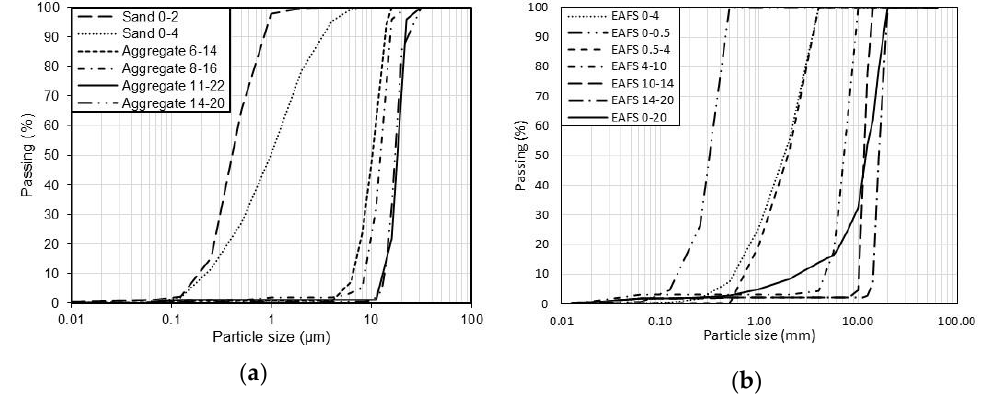
Figure 1. Particle size distribution of the used aggregates: ( a ) natural aggregates; ( b ) EAFS aggregates.